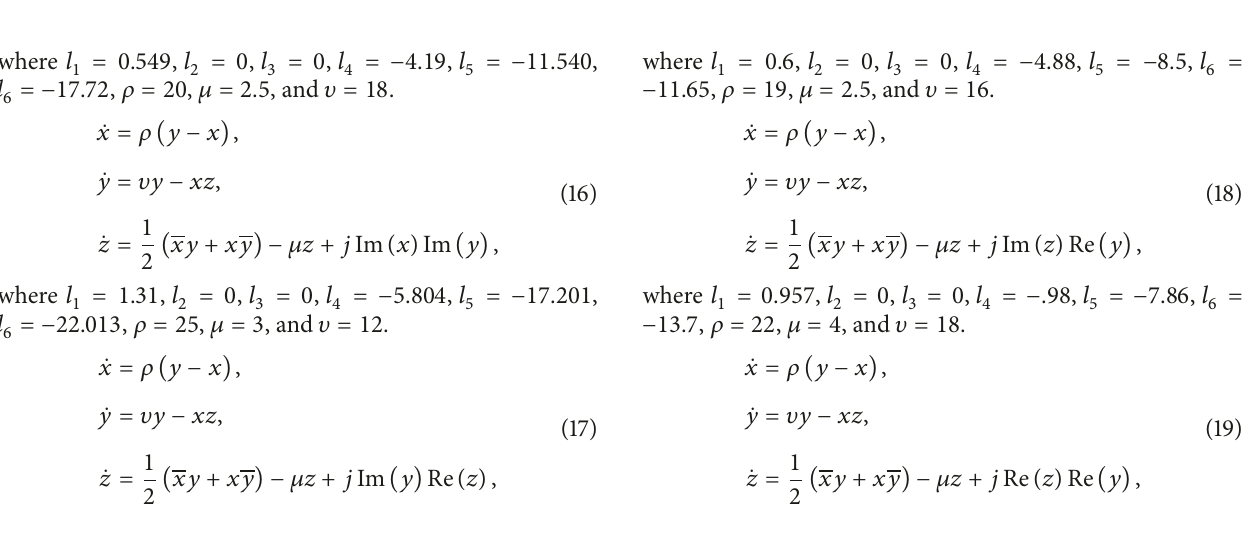
Figure 3: For 𝜐 = 10 and 𝜇 = 6 , vary 𝜌 . (a) Chaotic attractor, 𝜌 = 21 in (𝑤 1 , 𝑤 3 , 𝑤 5 ) . (b) Periodic attractor, 𝜌 = 23.9 in (𝑤 1 ,𝑤 3 ,𝑤 5 ) . (c) Quasiperiodic attractor, 𝜌 = 24.2 in (𝑤 1 ,𝑤 3 ,𝑤 5 ) . (d) Fixed point, 𝜌 = 30 in (𝑤 1 , 𝑤 3 , 𝑤 5 ) .